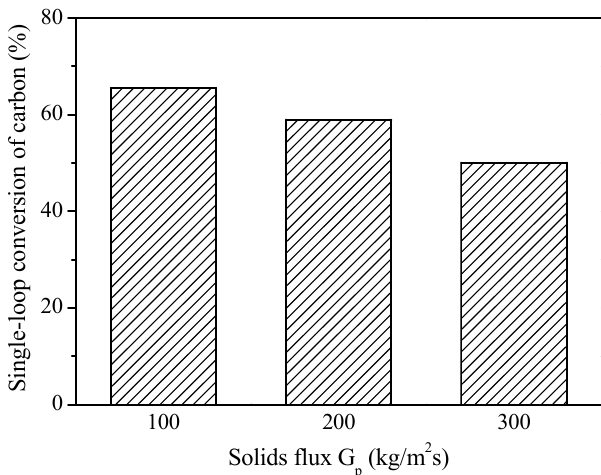
Figure 8. Effect of solids flux on the single-loop conversion of carbon in the fuel reactor.